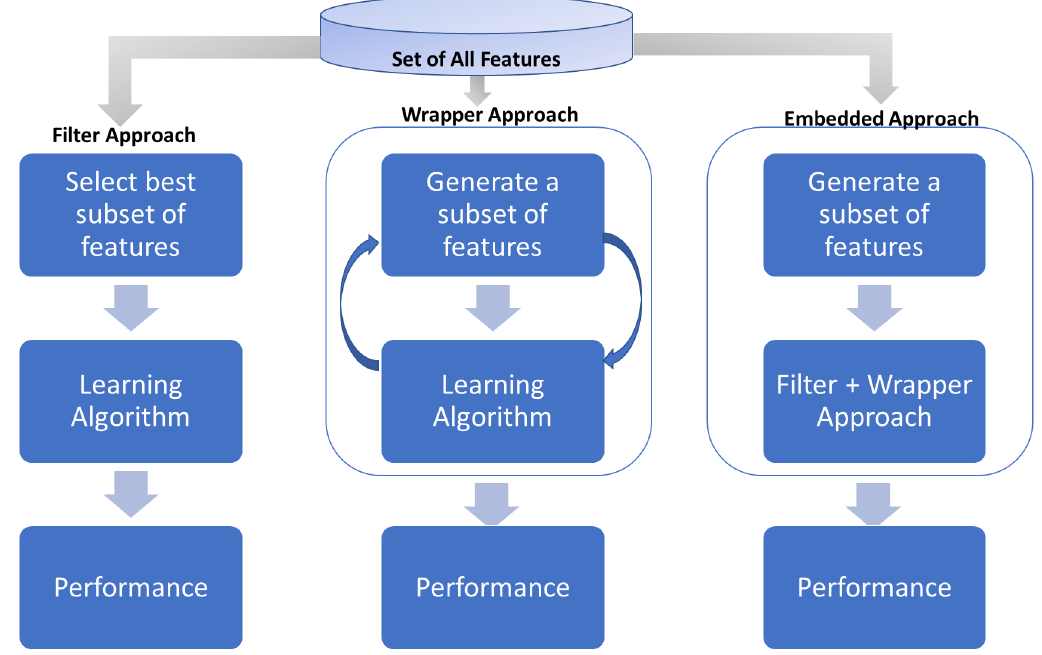
Figure 6. Flow diagram of different feature selection approaches.